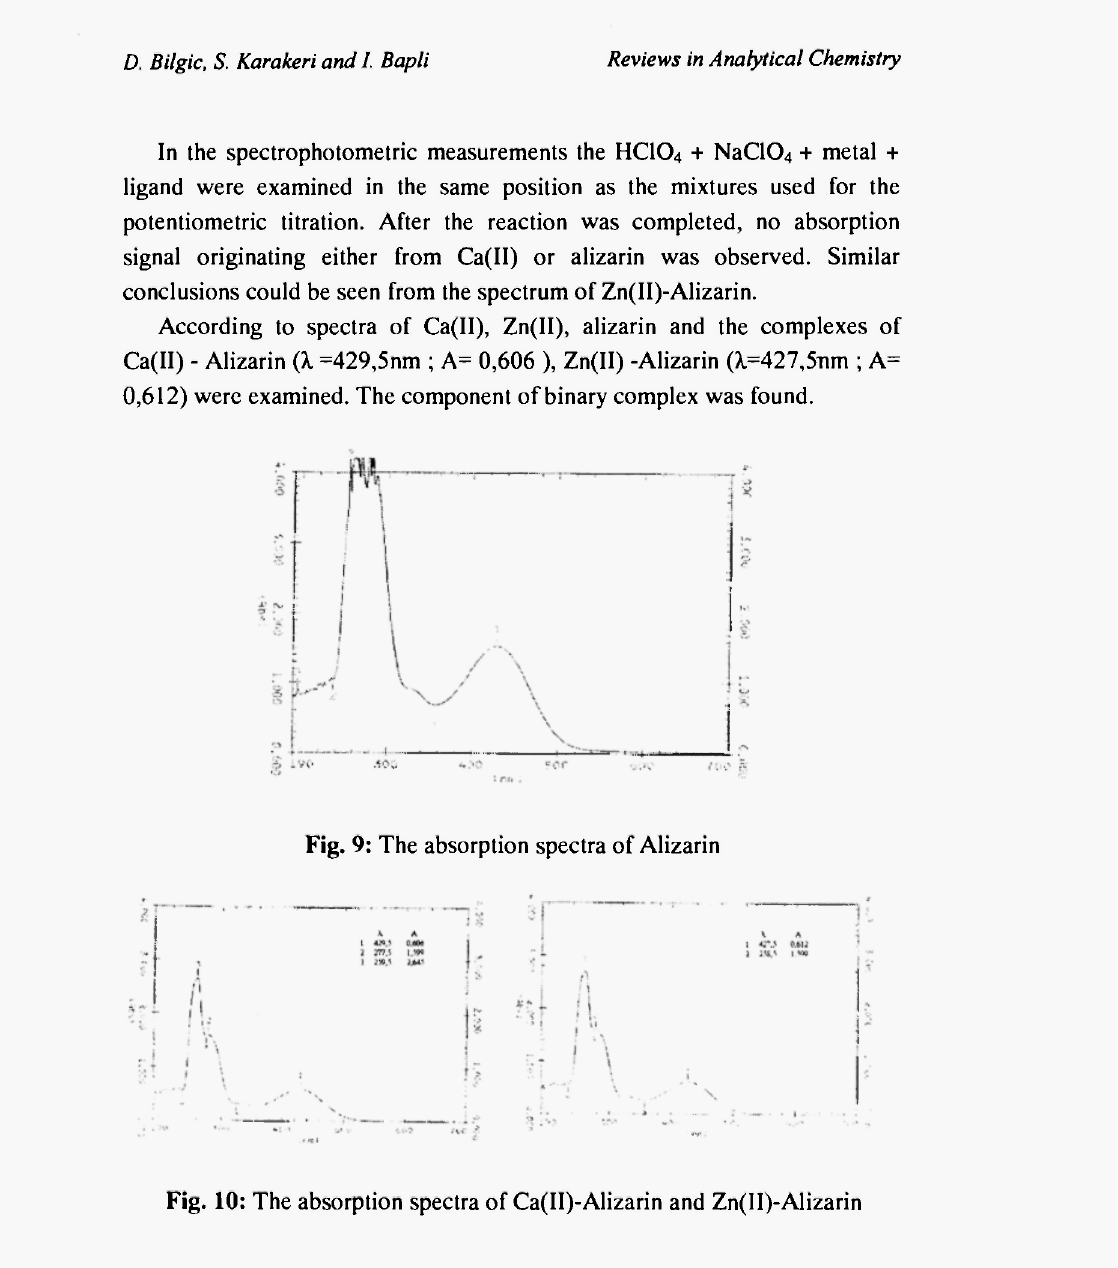
Fig. 10: The absorption spectra of Ca(II)-Alizarin and